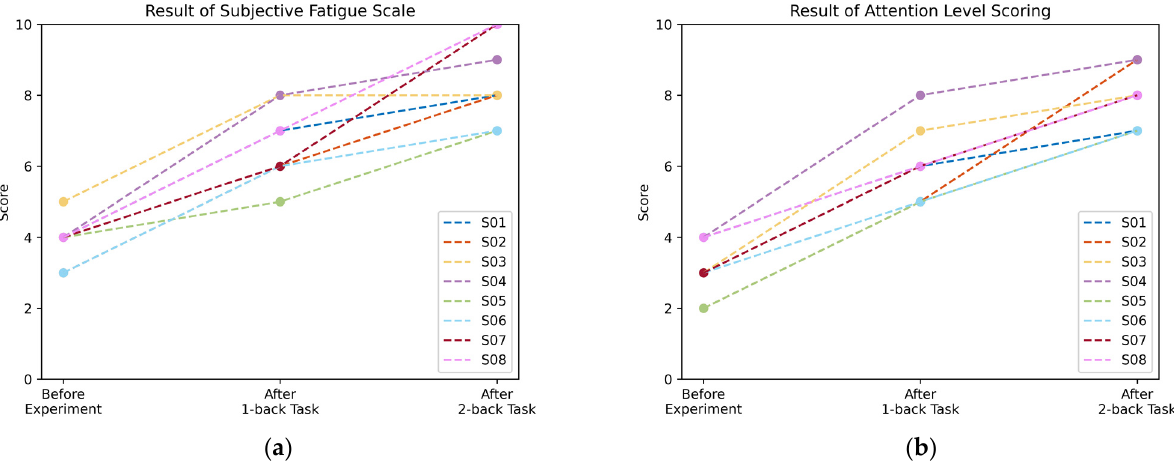
Figure 5. Subjective Scale Scores, ( a ) Fatigue, ( b ) Attention Level.